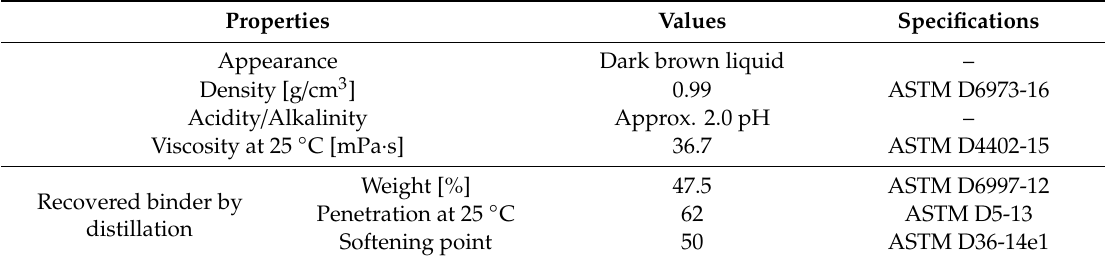
Table 2. Characteristics of bitumen emulsion for antiskid surface layer.